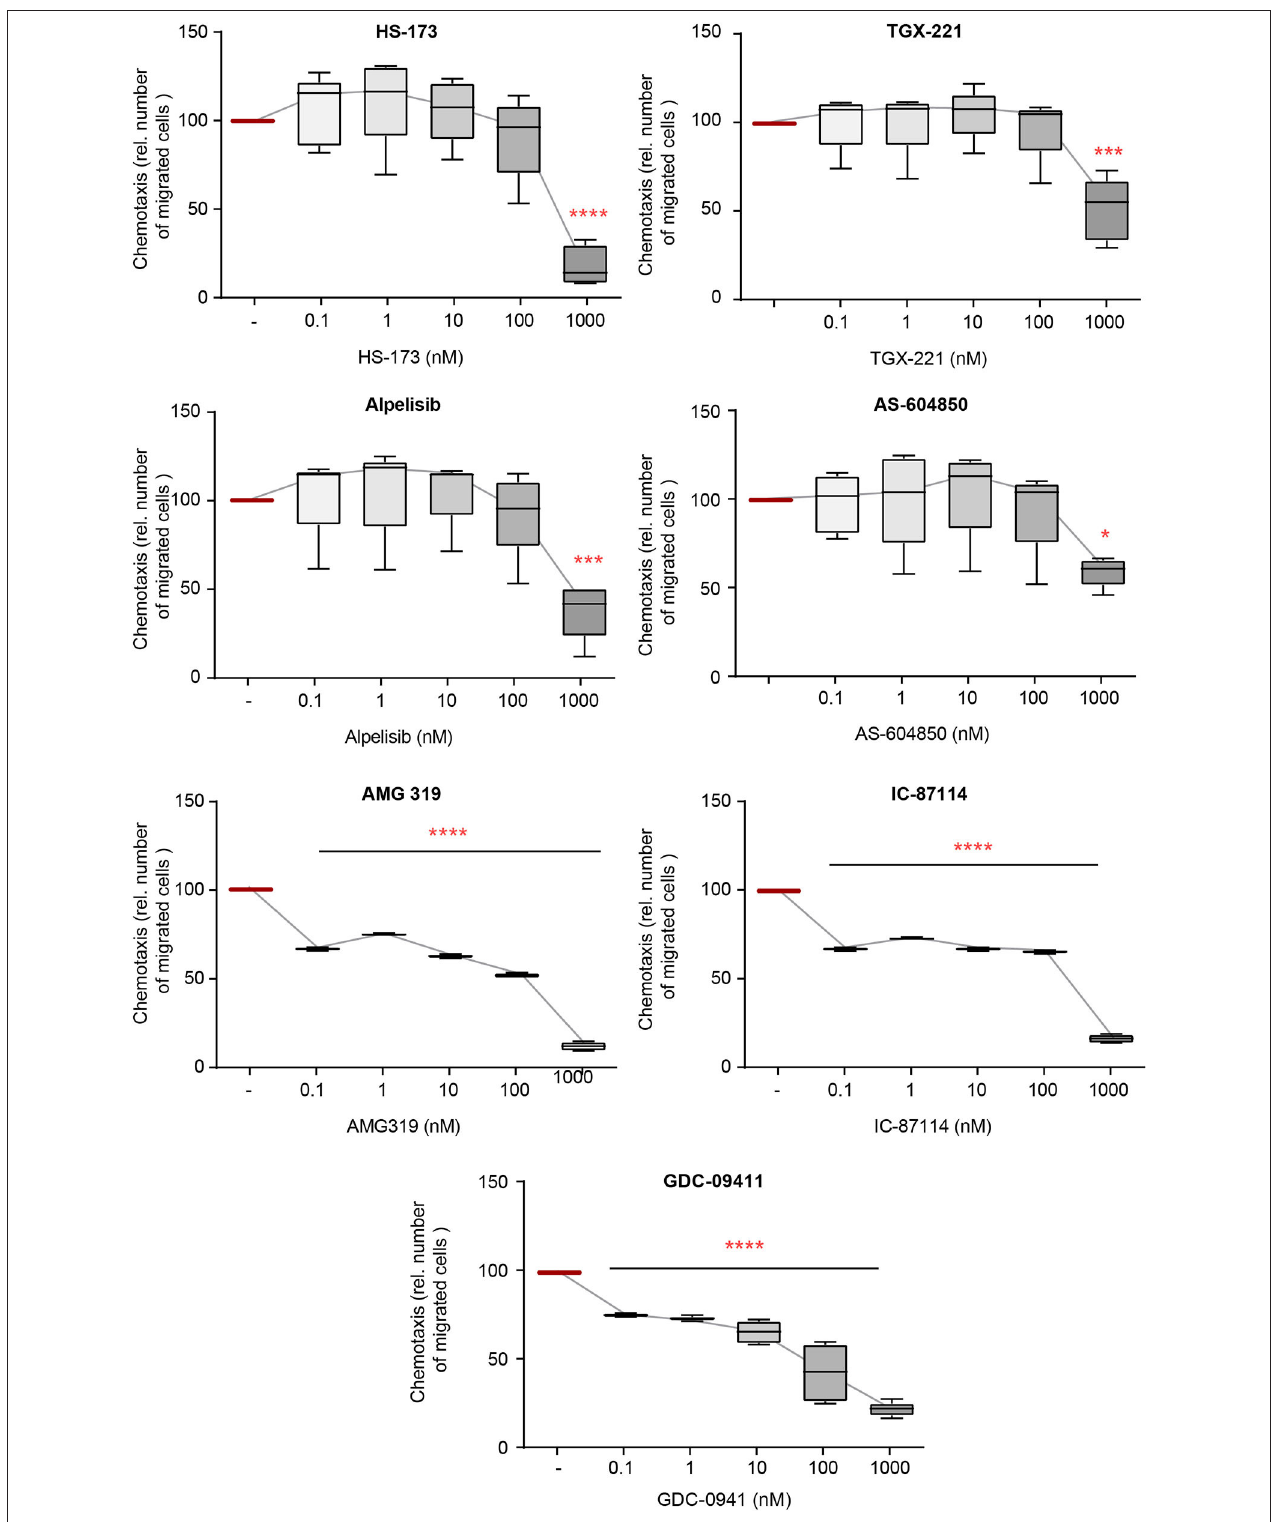
FIGURE 1 | IL-8-induced chemotaxis from PMNs depends on PI3K. Chemotaxis of PMNs was induced by IL-8 in the presence of either one of the PI3K isoform-selective inhibitors. The attracted cell number during a time period of 60min is shown. Data were normalized to positive control (chemotaxis induced by IL-8 in the presence of solvent). Data are shown as Tukey’s box-and-whisker plots. n = 5. ANOVA on ranks (Kruskal-Wallis) was applied followed by a Bonferroni t -test for multiple comparisons. * p < 0.05, *** p < 0.001, **** p < 0.0001.